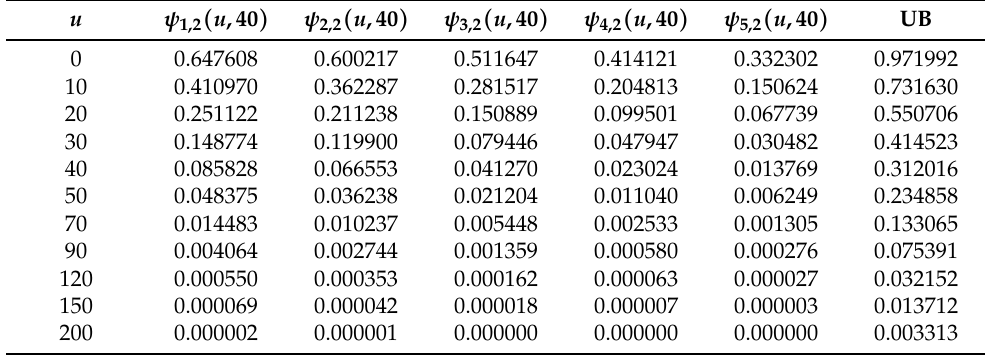
Table 8. ψ i ,2 ( u ,40 ) values with upper bounds (UB).